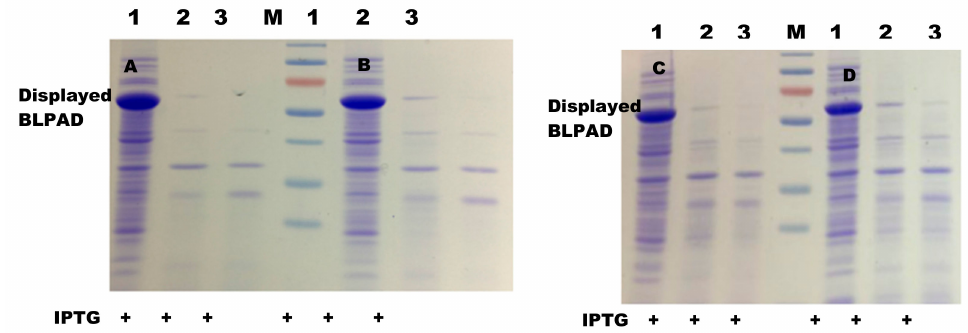
Figure 4. Protease accessibility analyses of the surface-displayed cells. ( A , B ) BL21(DE3) cells and BL21 (DE3) pLysS cells carrying a pET22b-pelblpad vector. ( C , D ) BL21(DE3) cells and BL21 (DE3) pLysS cells carrying a pET22b-gdsllpad vector, respectively. M: protein marker, Lane 1–3: the outer membrane fractions from no proteinase K treated cells, with 0.05 mg / mL proteinase K treated cells, and with 0.1 mg / mL proteinase K treated cells, respectively. PrK: proteinase K; IPTG: isopropyl β